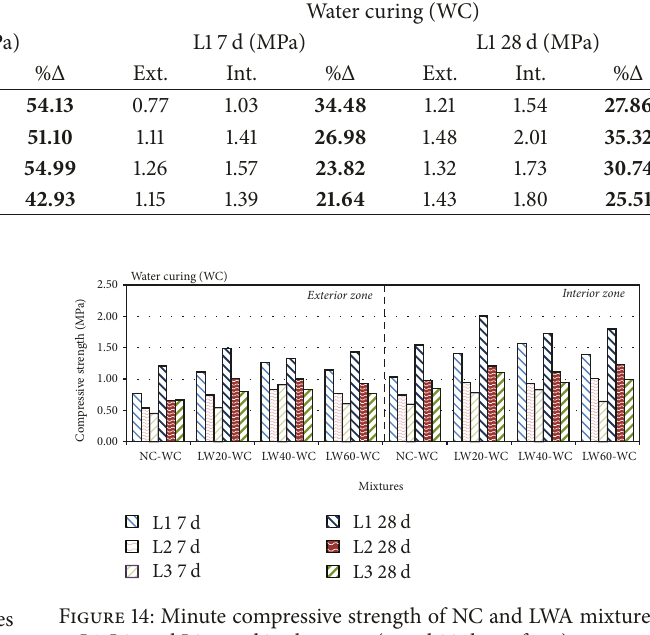
of AAC-LWA replacement as extra water on aggregate’s surface was obtained. However, flow values of all mixtures were similar to normal weight aggregate concrete (NC) and classified as medium consistency category with the flow of 50 to